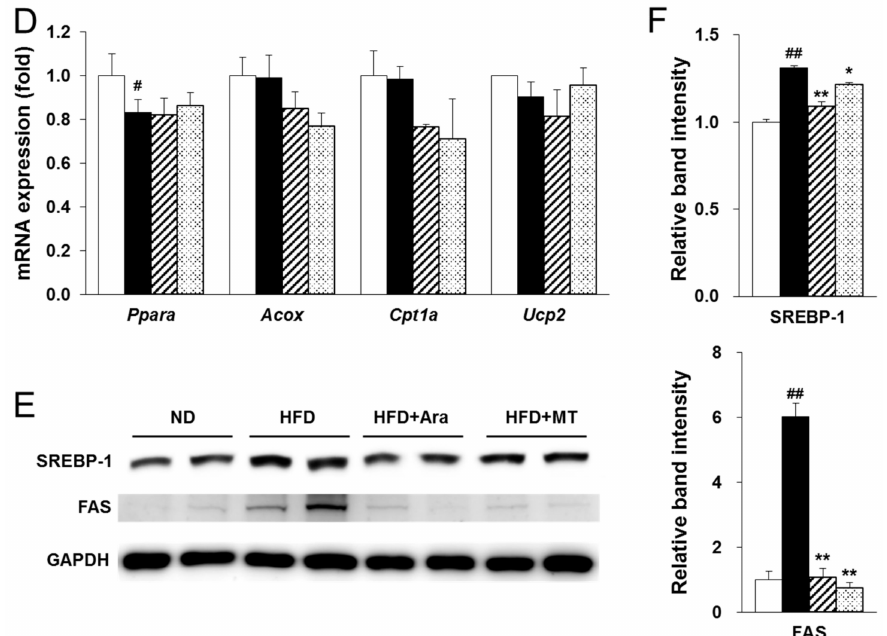
Figure3. Arazymereducedlipogenesis-relatedgeneandproteinexpressionintheliver. MLXinteracting